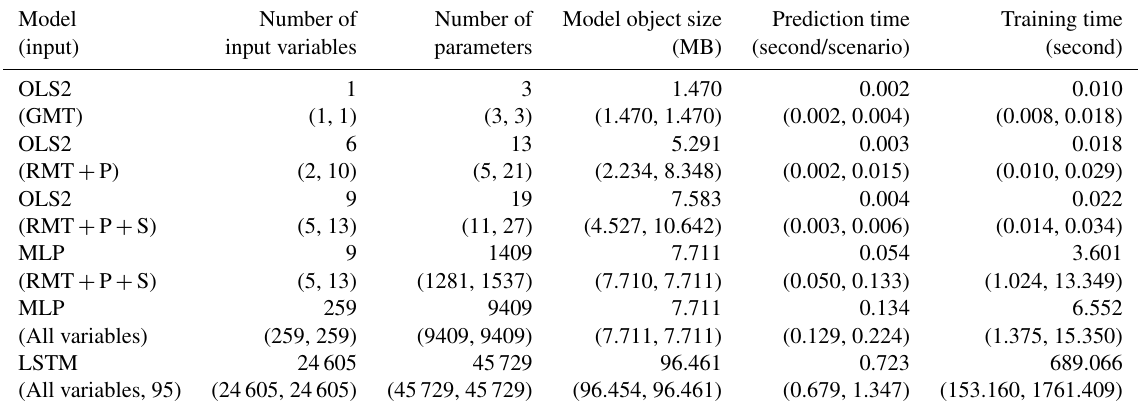
Table 7. Computational cost of the developed emulators. Medians (minimum, maximum) of 17 regional, 9 sectoral, and aggregated impact results are shown. OLS-based models and ANN-based models were implemented by the statsmodels library and Keras library in Python, respectively. OLS2 (RMT + P + S): OLS2 with regional mean temperature precipitation and socioeconomic variables. MLP (RMT + P + S): MLP with regional mean temperature precipitation and socioeconomic variables. MLP (All variables): MLP with all the input variables. LSTM (All variables, 95): LSTM with all the input variables for 95 years. Model Number of Number of Model object size Prediction time Training time (input) input variables parameters